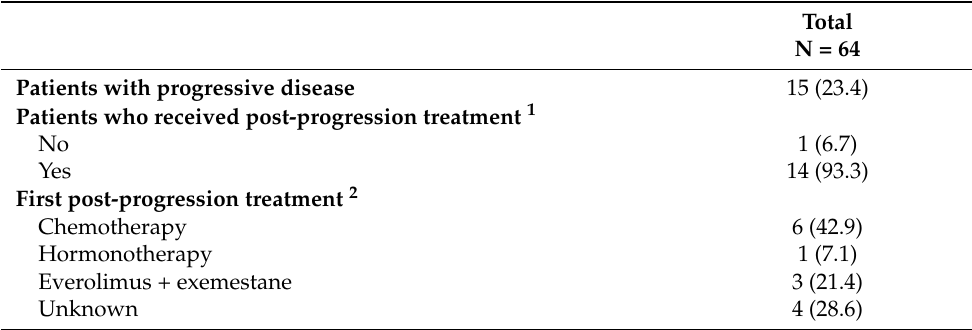
Table 3. First post-progression treatment. All data are presented as frequencies (N (%)) unless